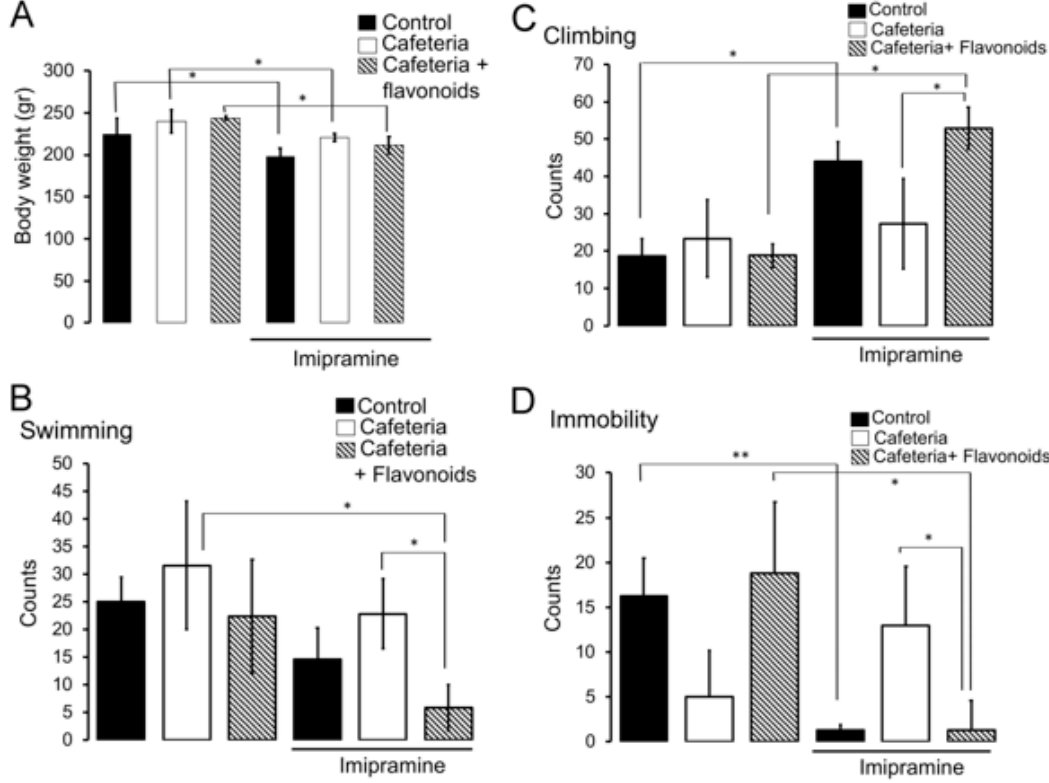
Figure 4. Flavonoids revert depressive-like behavior induced by cafeteria diet exposure. ( A )